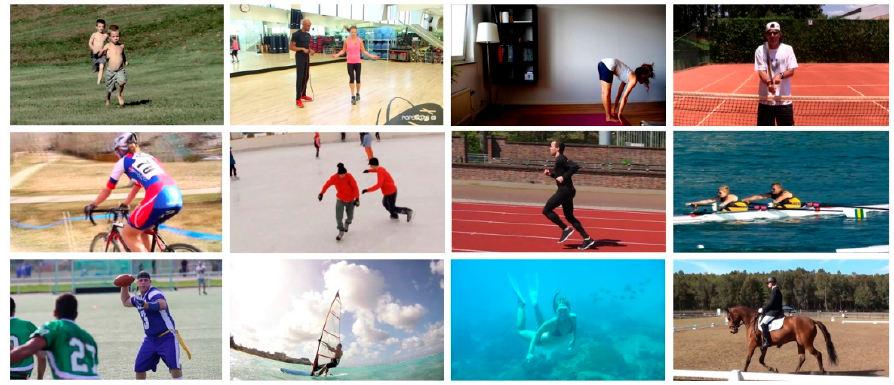
Figure 6. Images from the MPII dataset.